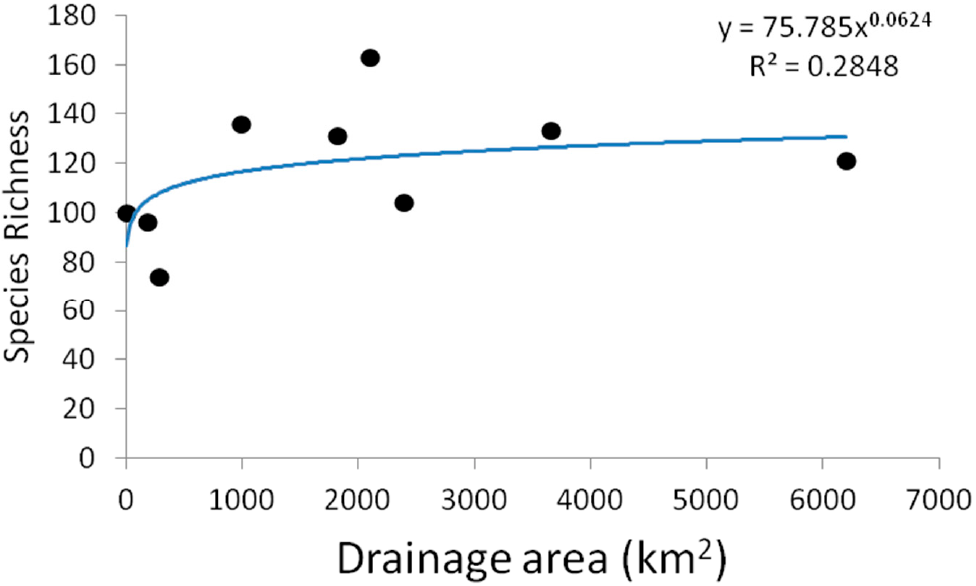
Figure A3. Species–area relationship for the sampled rivers. There is no clear evidence that species richness increases with increased drainage area.